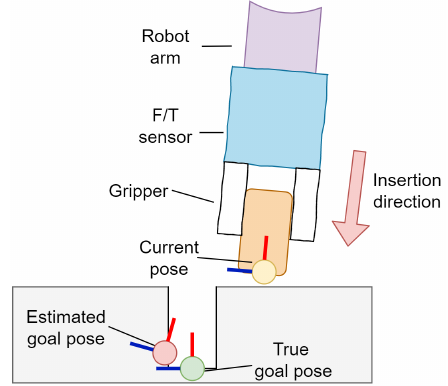
Figure 1. Insertion task with uncertain goal